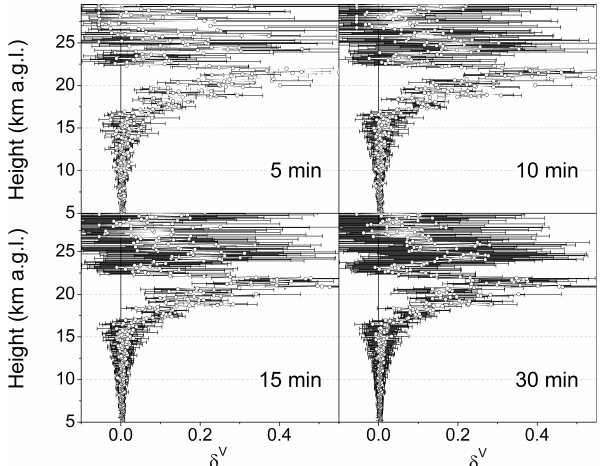
− δ V ) differences along an hour and Fig. 3. MPL-4 mean ( δ V 1 - min their RMS values (for instance, data on 1 July